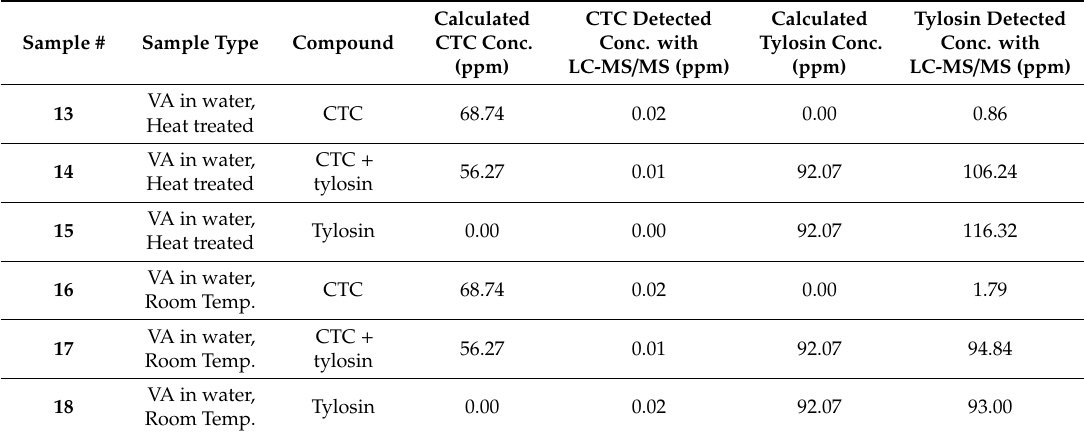
Table 8. Comparison of calculated VAs concentrations and LC-MS / MS detected